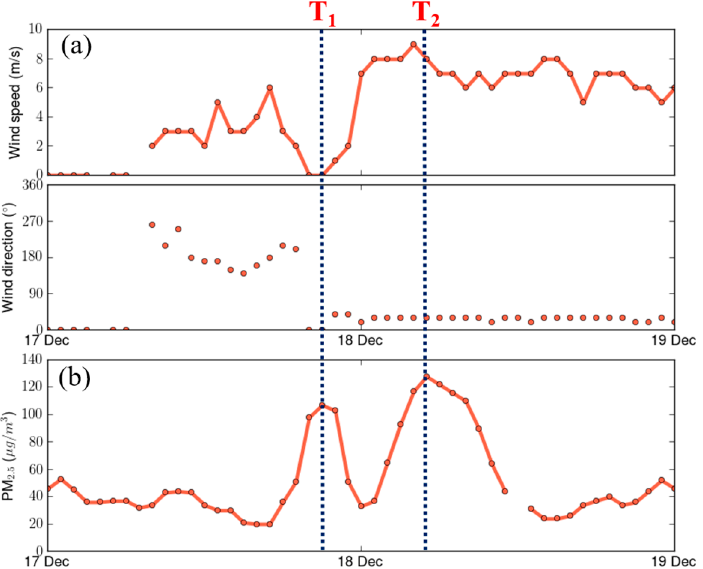
Figure 6. Time series of ( a ) wind and ( b ) PM 2.5 concentration in Fuzhou from 17 to 18 December 2019. The two PM 2.5 peaks at 21:00 p.m. LST on 17 December and 5:00 a.m. LST on 18 December are marked as T 1 and T 2 , respectively.